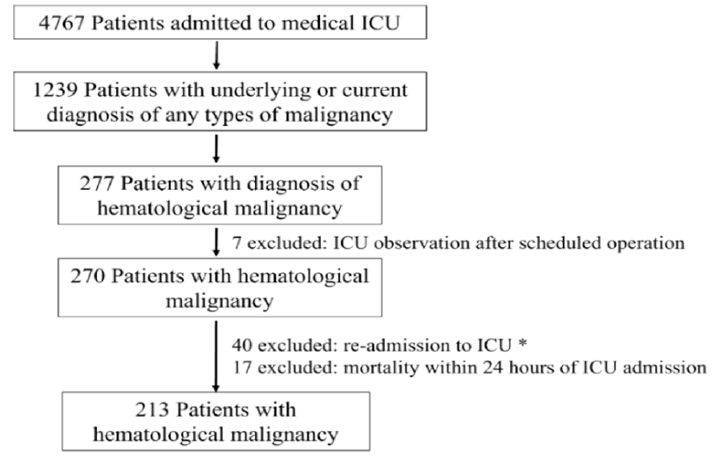
Figure 1. Study design and flow chart. ICU, intensive care unit. * If the patient was admitted to the ICU more than once, the first admission was included